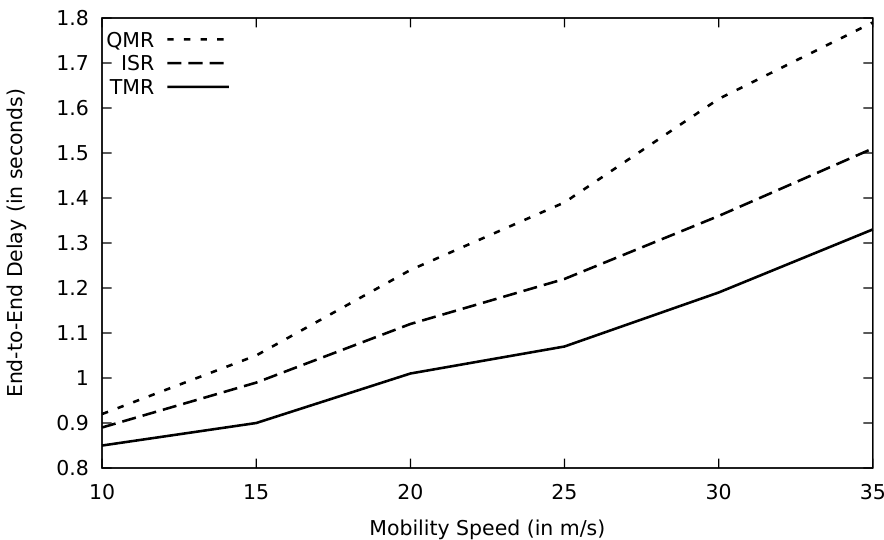
Figure 30. Comparison of QMR, ISR, and proposed protocol TMR for end-to-end delay with mobility speed.